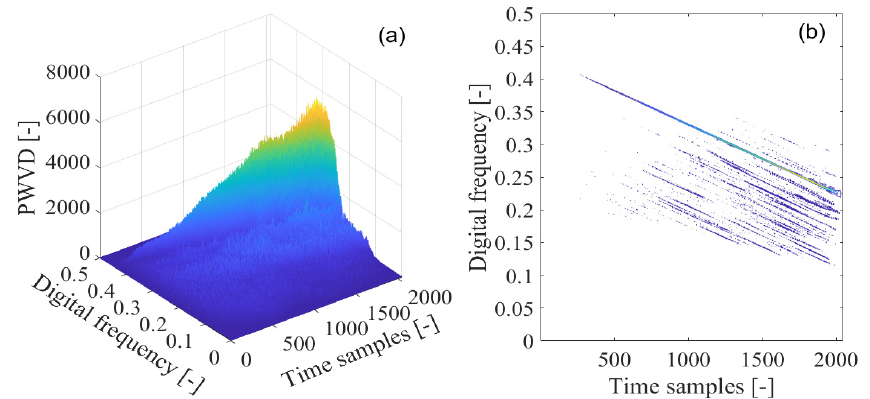
Figure 12. The pseudo-Wigner–Ville distribution (PWVD) of the GPS L1-C/A signal disturbed by the sweep interference; ( a ) PWVD; ( b ) PWVD’s contour.